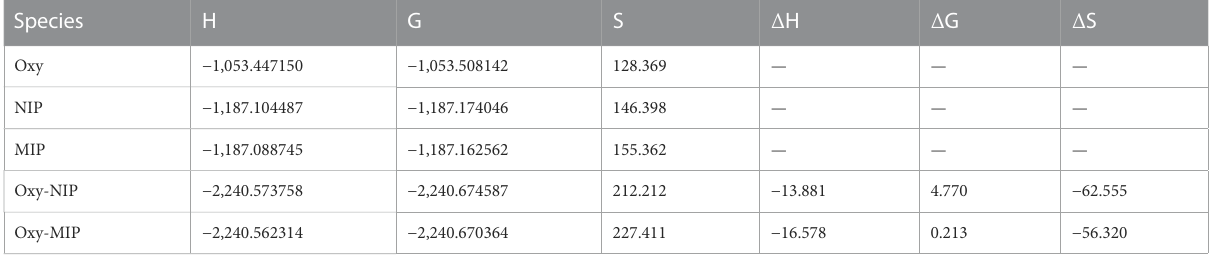
TABLE 4 The key thermodynamic as well as UV-visible adsorption parameters containing H (Hartree/particle), G (Hartree/particle), S (Cal mol − 1 K − 1 ), λ max (nm) Δ H (kCal mol − 1 ), Δ G (kCal mol − 1 ), Δ S (Cal mol − 1 K − 1 ) for each considered species. Species